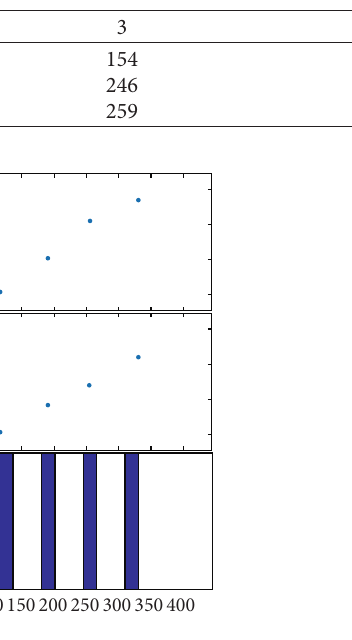
Table 5: Query rate comparison (predicate).